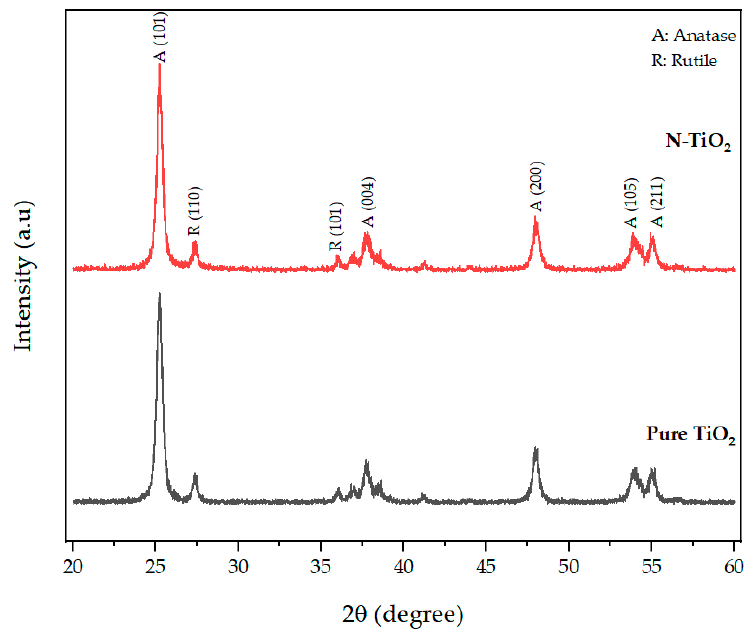
Figure 1. XRD patterns of TiO 2 and nitrogen-doped TiO 2 .